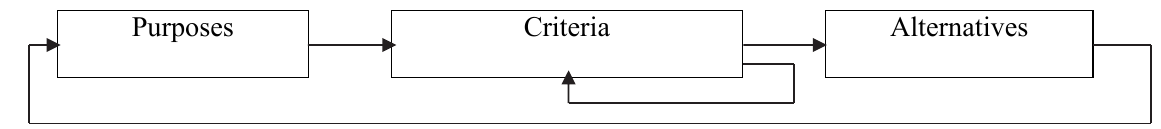
Fig.1. Feedback system model